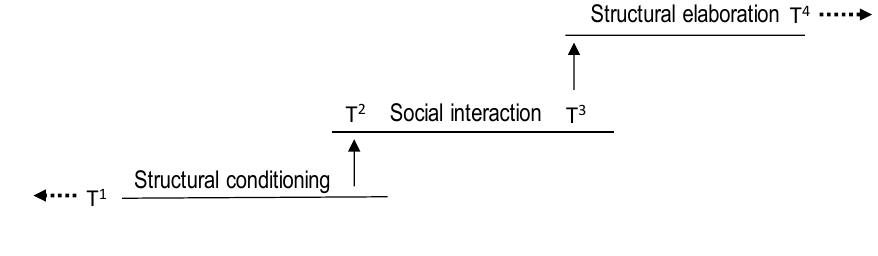
Figure 1. The morphogenetic sequence (based on [24, p.